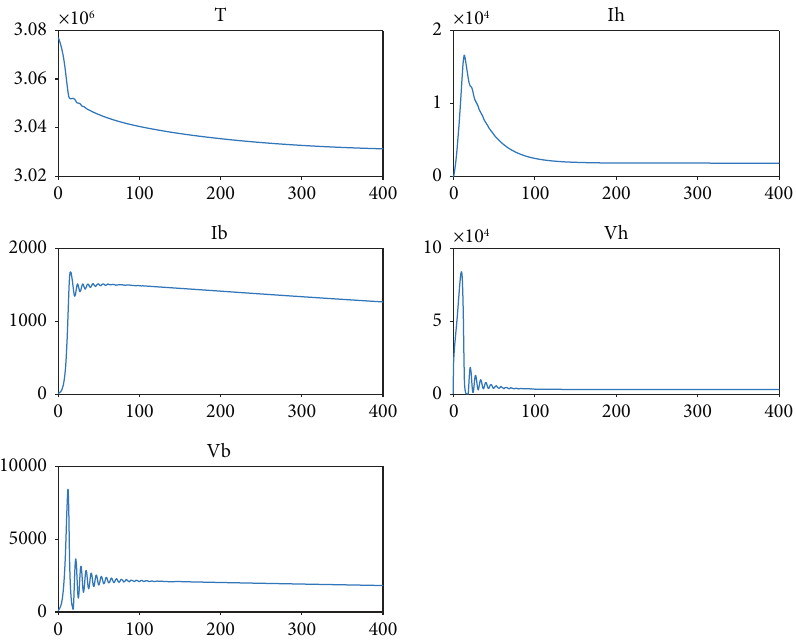
Figure 5: Delayed HIV/HBV model with optimal control. Parameter values are as shown in Table 1. Horizontal axes represent time in